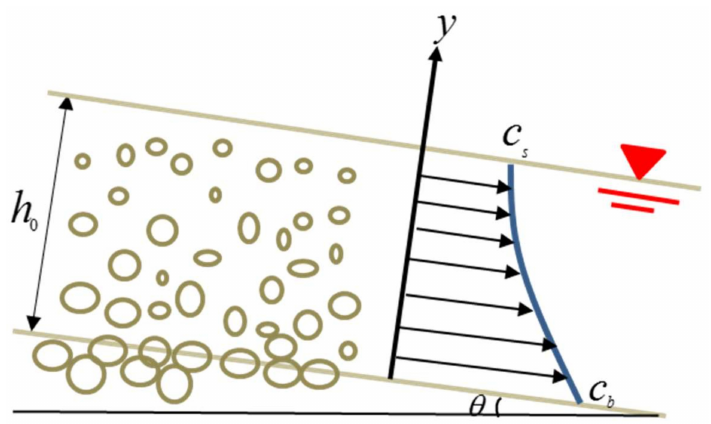
Figure 1. Schematic of steady and uniform debris